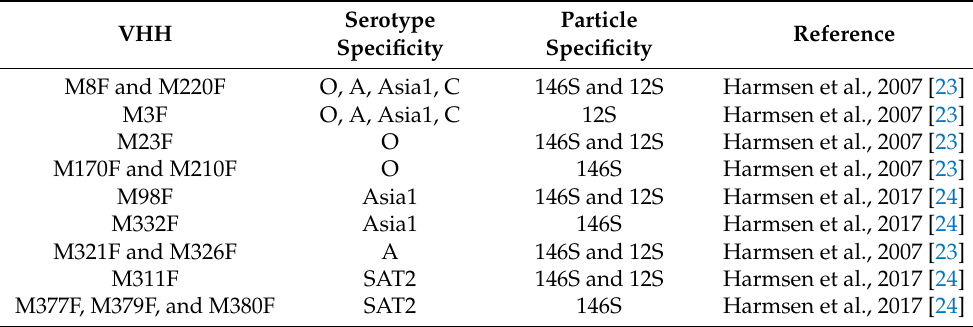
Table 1. Previously isolated VHHs used for phage display selection and